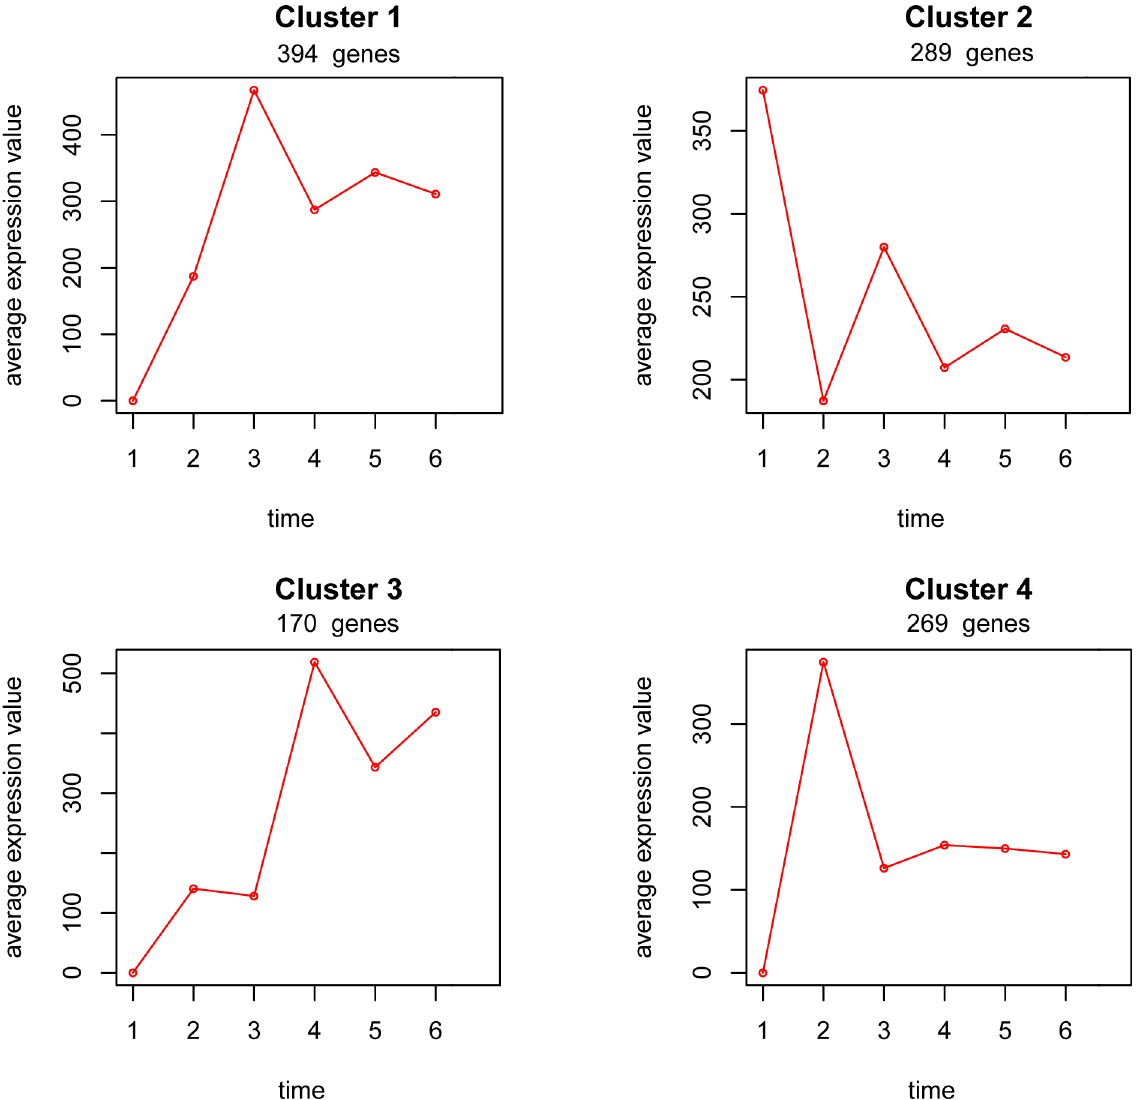
Fig 2. N . ceranae gene expression pattern during the infection period. There were 1122 genes significantly differentially expressed during the infection period, clustering into 4 expression patterns based on the expression levels as above. The X axis represents post-infection day and the Y axis represents average counts of clustered